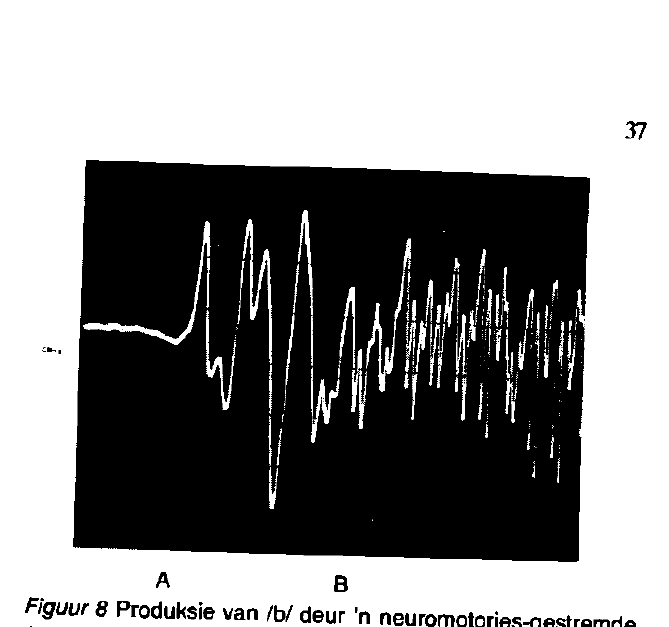
Die Stemaanvangstyd van Apraktiese en Disartriese